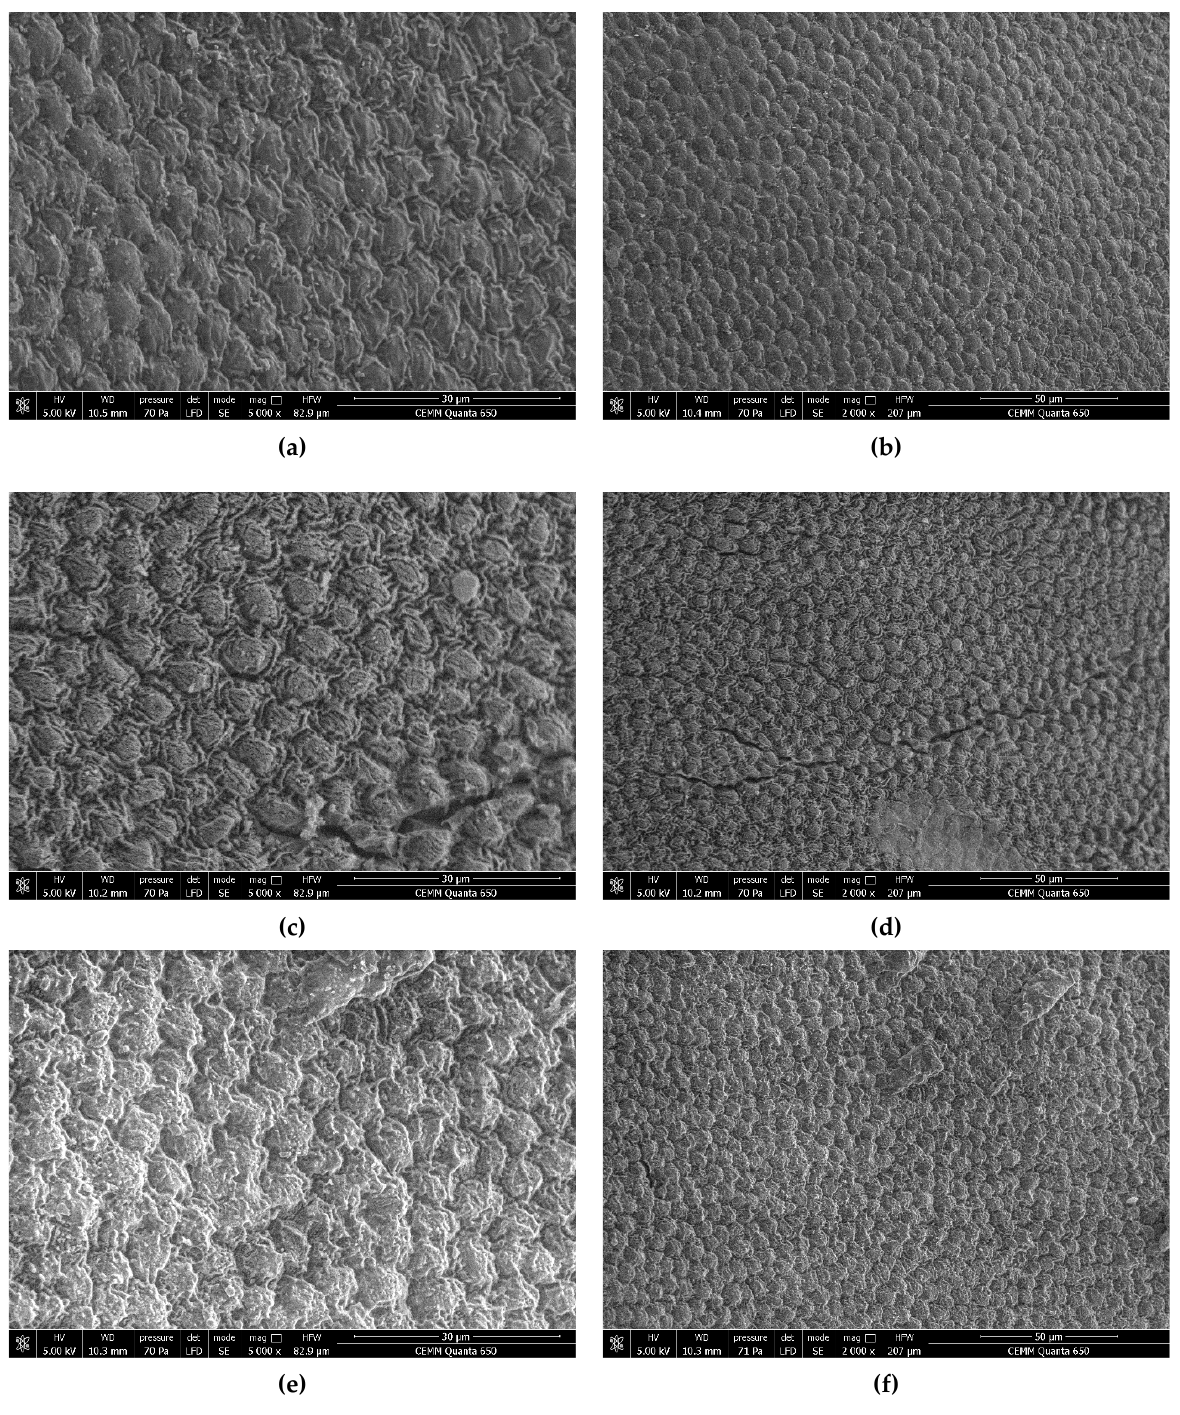
Figure 4. Alfalfa seed surface as seen using SEM; ( a , b )—untreated; ( c , d )—E-mode treatment for 120 s; ( e , f )—H-mode treatment for 5 s. ( a , c , e ) — 5000× magnification; ( b , d , f ) — 2000× magnification. ( e , f )—H-mode treatment for 5 s. ( a , c , e )—5000 × magnification; ( b , d , f )—2000 ×